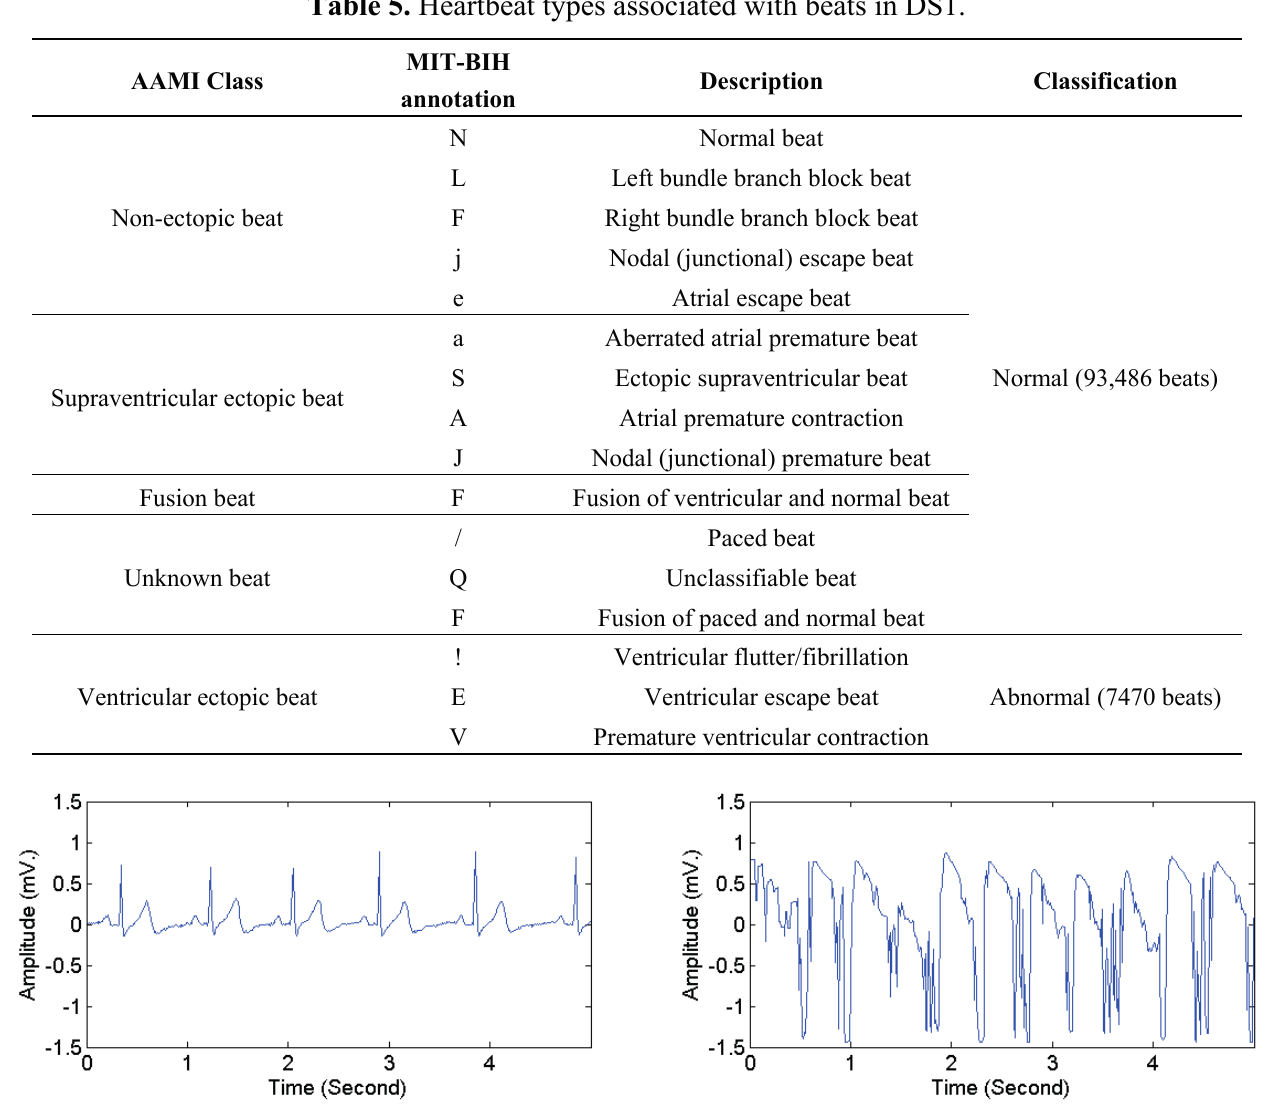
Figure 6. Examples of high quality ECG signals ( Left ) and low quality ECG signals ( Right